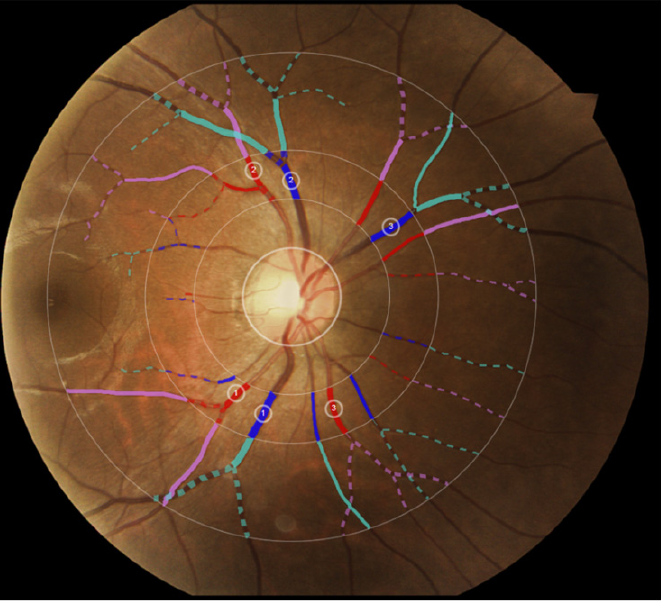
Figure 3. Example demonstration of the six major vessels (three arteries and three veins) used in computing VASP parameters. Vessels in different zones are represented in different colours for il- lustration purposes.